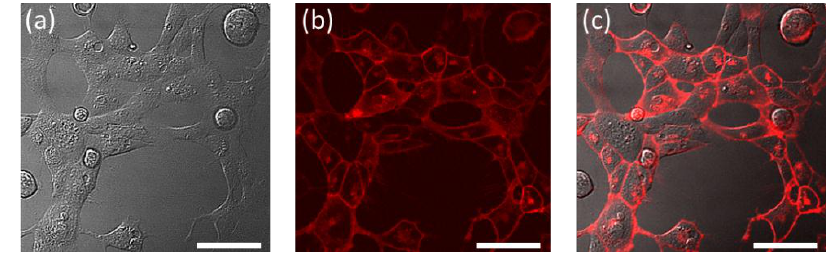
Figure 1. ( a ) Bright field image, ( b ) fluorescence image, and ( c ) merge of human embryonic kidney 293 (HEK293) cells after staining with ampicillin-modified tetramethylrhodamine (TMR). Scale bar shows 50 µm.